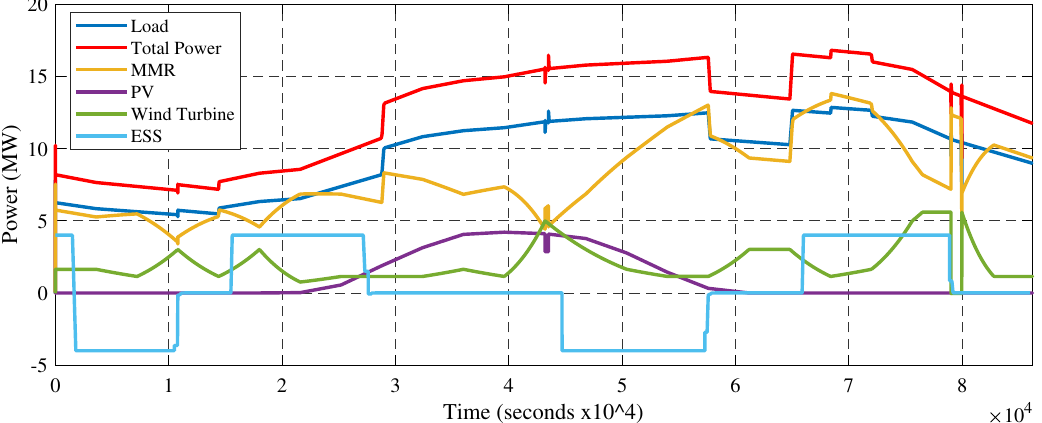
Figure 8. Performance of the HES with conventional EMS.